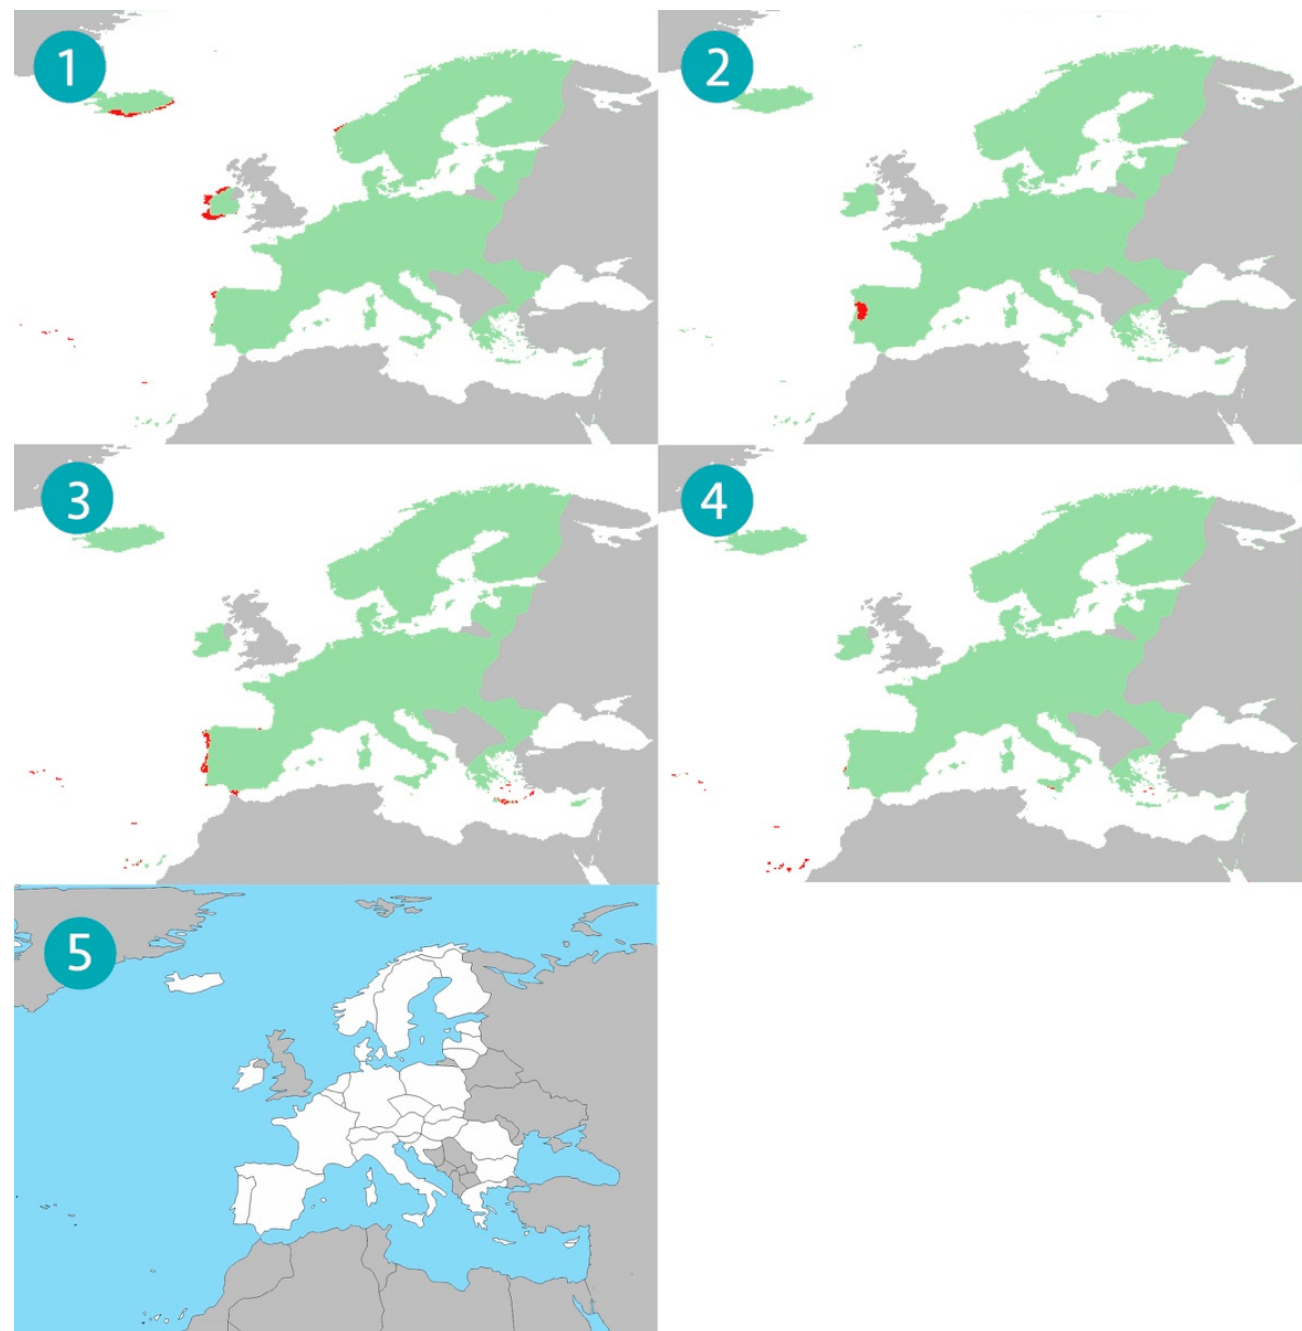
Figure 2. The prediction computed using the MaxEnt model of the pet-traded gastropods with potential occurrence in a “medium area” of EU (= covering less than 5% of the territory). The maps show suitability in red, representing a high probability of establishment for these species: ( 1 ) Acavus superbus , ( 2 ) Archachalina ventricosa , ( 3 ) A. marginata , and ( 4 ) Lissachatina allisa ; ( 5 ) map of European Union.